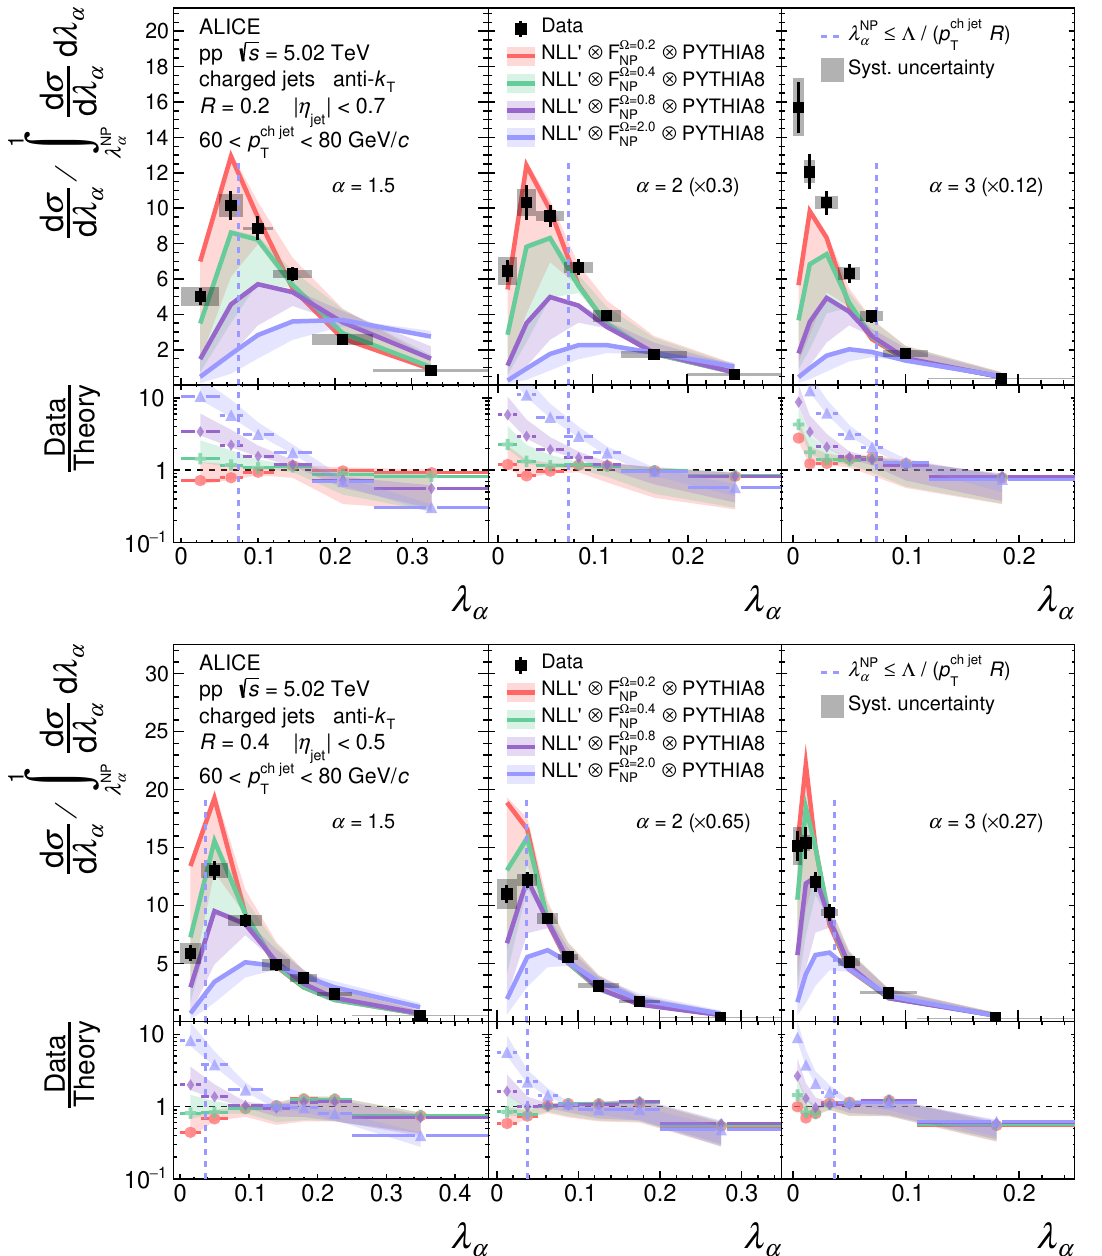
Figure 7 . Comparison of ungroomed jet angularities λ α in pp collisions for R = 0 . 2 (top) and R = 0 . 4 (bottom) to analytical NLL 0 predictions using F ( k ) convolution in the range 60 < p ch jet GeV /c . The distributions are normalized such that the integral of the perturbative region defined by λ α > λ NP (to the right of the dashed vertical line) is unity. Divided bins are placed into the left α (NP)